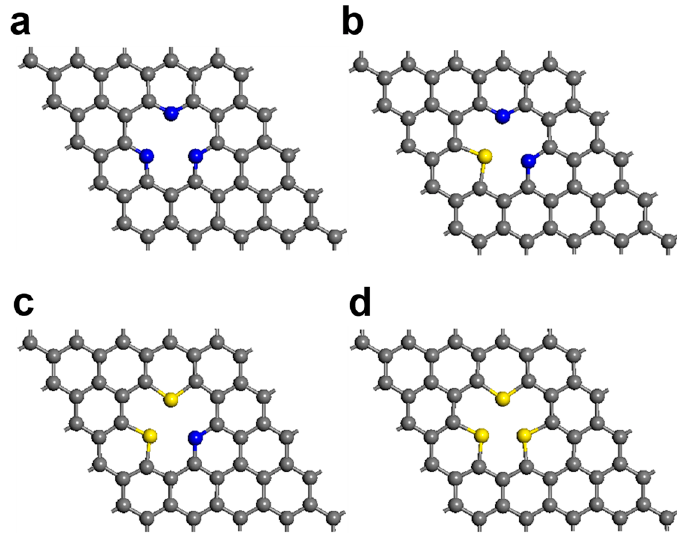
Figure 1. Optimized structures of the ( a ) 3N-gra, ( b ) 2N1S-gra, ( c ) 1N2S-gra, and ( d ) 3S-gra systems. Blue, gray, and yellow denote nitrogen, carbon, and sulfur, respectively.